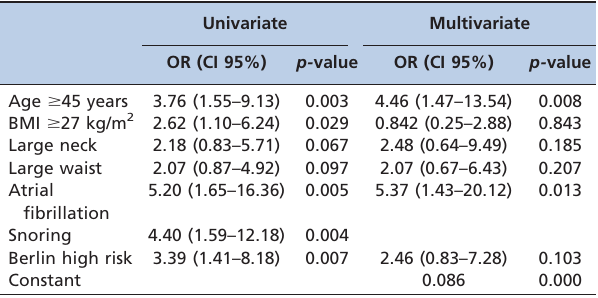
Table 3 - Binary logistic regression with the predictors of obstructive sleep apnea among patients with hypertrophic